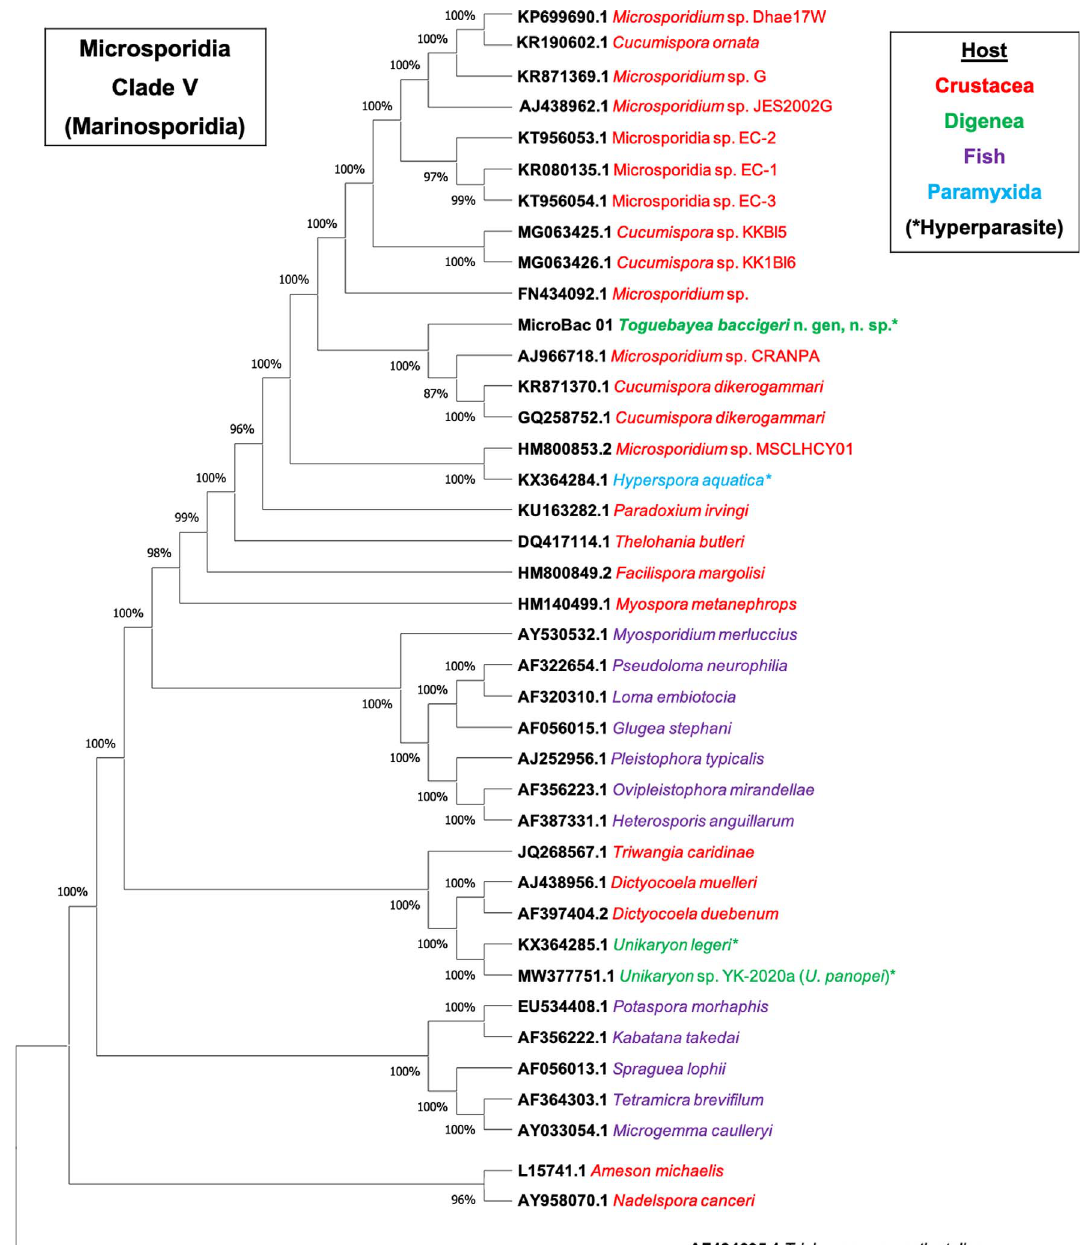
Figure 1. Maximum Likelihood phylogenetic analysis of Microsporidia sequences based on the SSU rDNA gene. Trichonosema pectinatellae (AF484695.1) was used as the outgroup. MicroBac01 corresponds to the sequence obtained for Toguebayea baccigeri n. gen., n.